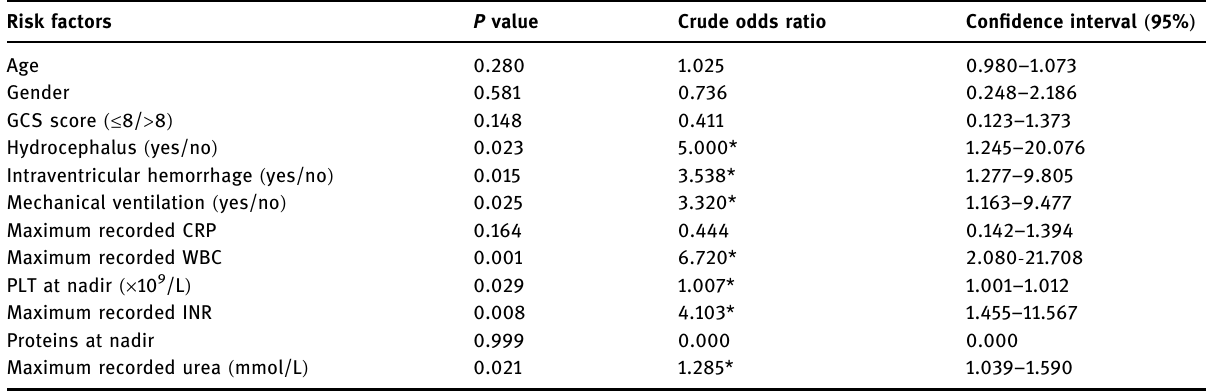
Table 2: Univariate analysis of factors associated with CVS ( majority of the factors without signi fi cant in fl uence were omitted for the sake of clarity )